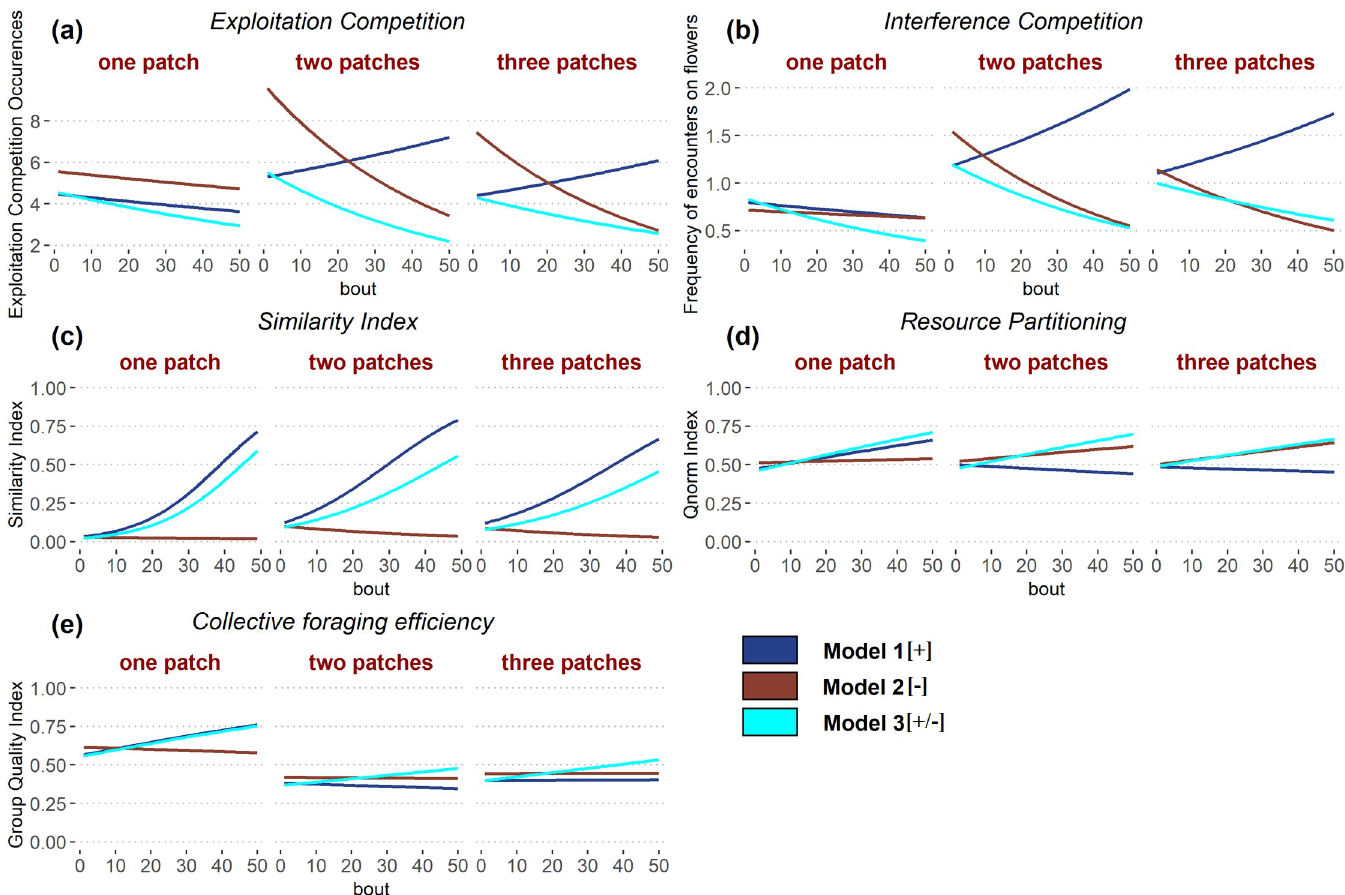
Fig 3. Model comparisons for observed variables. Results of simulations with two foragers in environments with 10 flowers. See details of models in Fig 1. The x axis is the number of completed foraging bouts by the two foragers. The y axis represents respectively: (a) the estimated mean frequency of visits to empty flowers; (b) the estimated mean frequency of encounters on flowers; (c) the similarity index SI between two successive flower visitation sequences; (d) the index of resource ab partitioning Q norm (0: both bees visit the same set of flowers; 1: bees do not visit any flower in common); (e) the collective foraging efficiency index QL group . Average trends for each model are estimated across all types of environments (one patch, two patches and three patches; see S2 Fig).